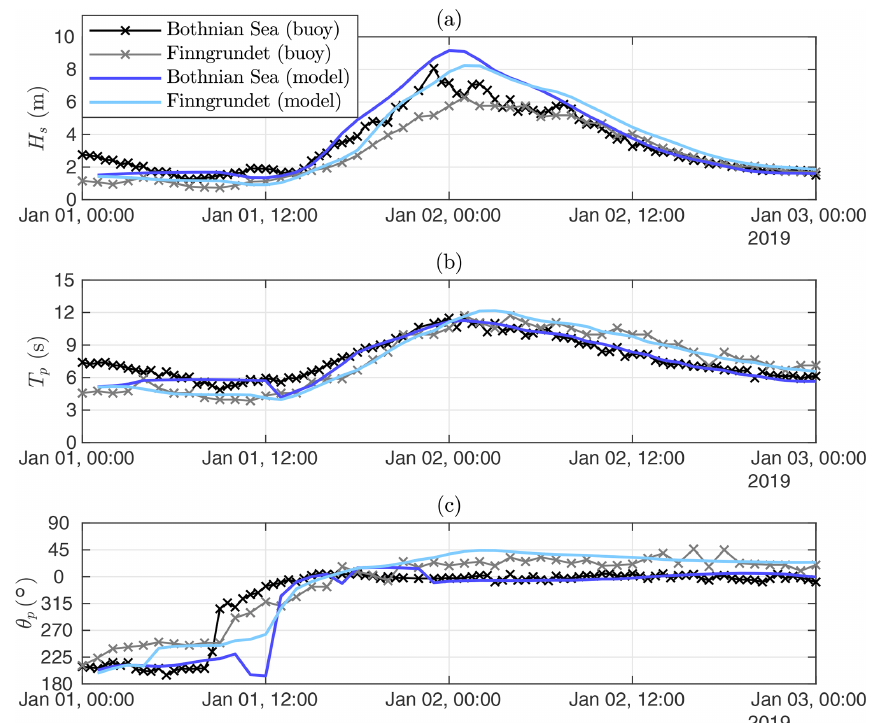
Figure 5. The significant wave height ( H s ), peak period ( T p ), and mean direction at the spectral peak ( θ p ) at the Bothnian Sea and Finngrundet wave buoys. The WAM model hindcast is forced with HARMONIE using a similar set-up as the CMEMS BAL MFC wave forecast. This figure shows the original (non-calibrated) hindcast.